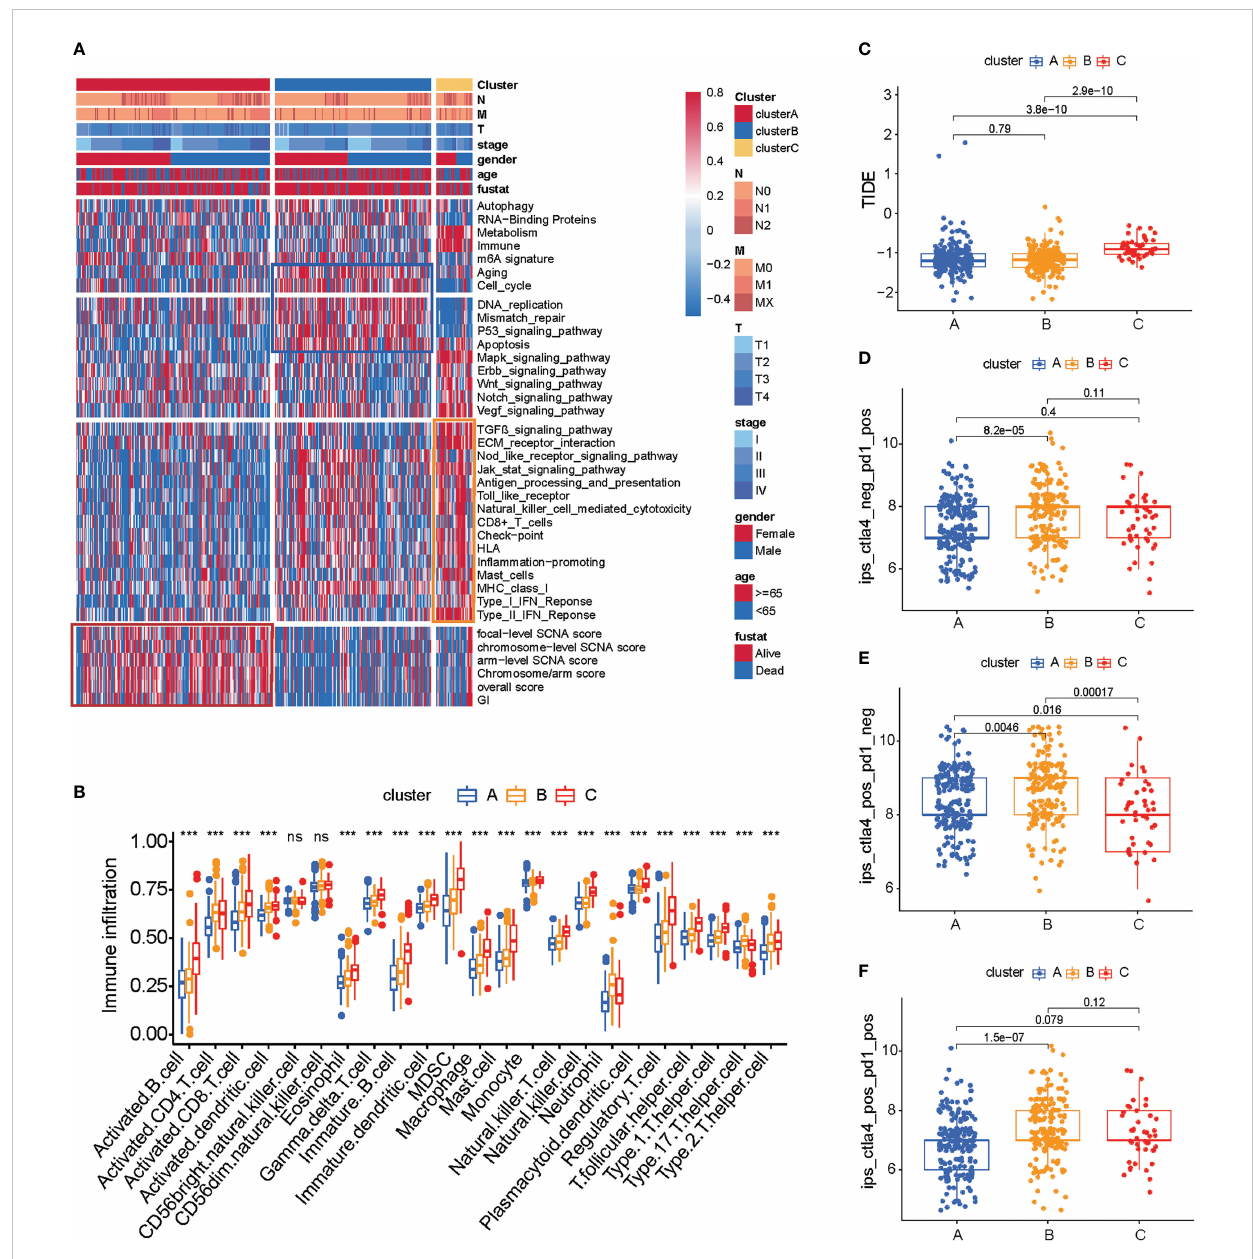
FIGURE 2 TME cell in fi ltration characteristics and immunotherapy prediction in distinct three subtypes of colon cancer. (A) Heat map of molecular characteristics in three clusters in TCGA-COAD cohort. The four regions (rows) of the heat map respectively represent key tumor processes, tumor- related pathways, immune-related processes, chromosome stability, and somatic cell copy number. (B) Analysis of immune cell content in TCGA COAD cohort. The one-way ANOVA test was used for comparison between different groups. *** p < 0.001, ns p > 0.05. (C) Heat map of hot or cold tumor marker genes in TCGA-COAD cohort. (D – F) The relationship between immunotherapy-related scores and patient subtypes in TCGA-COAD cohort. The Wilcoxon test was used for comparison between different